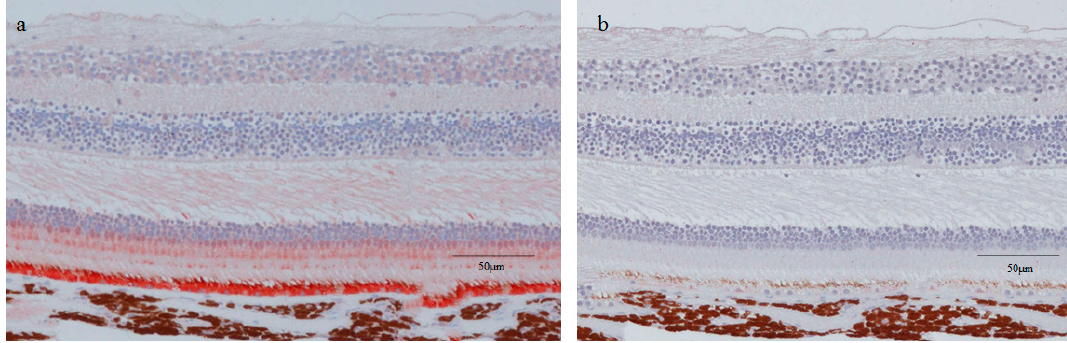
Figure 5. RPE65 and pan-CK immunostaining of the normal healthy retina of a monkey eye. An excised normal healthy retina of a cynomolgus monkey was used to perform the immunostaining with RPE65 ( a ) and pan-CK ( b ). The neural retina was not stained with RPE65 or pan-CK.